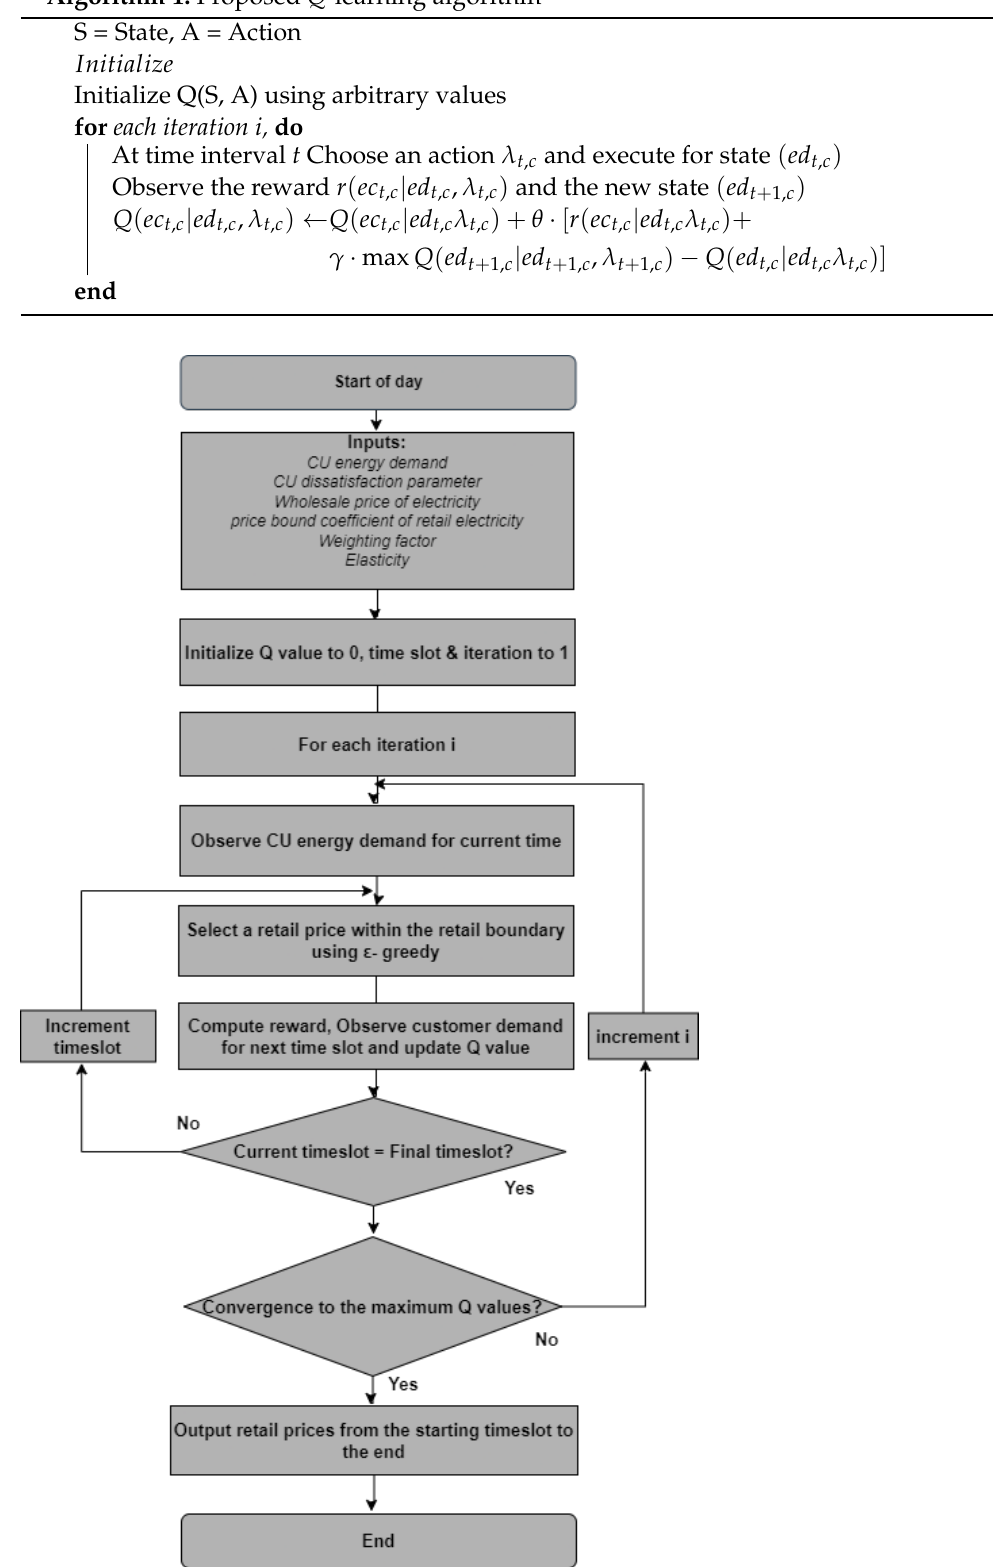
Figure 4. Flowchart for implementing the Q -learning process for figuring out the optimal